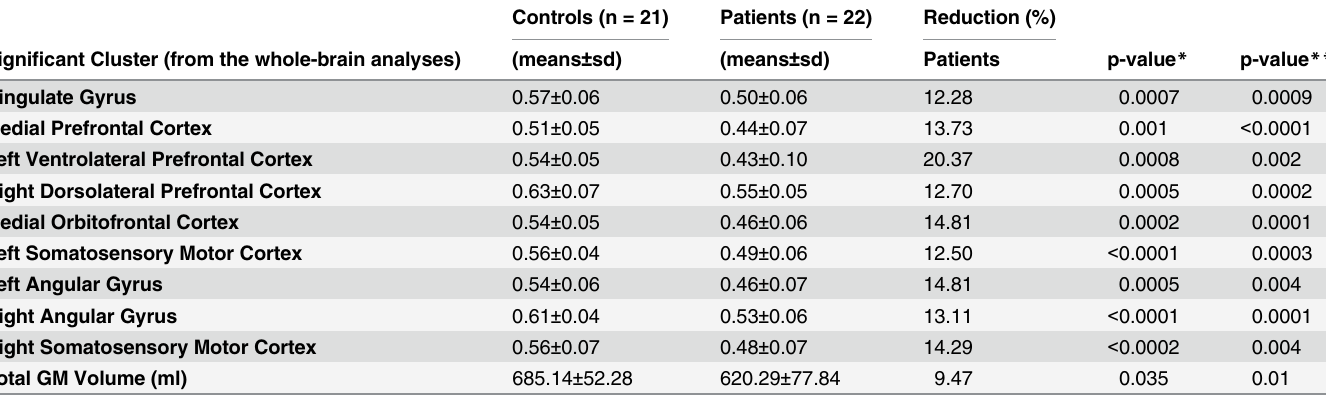
Table 3. ROIs where GM volumes in female controls exceeded GM volumes in SCP patients.